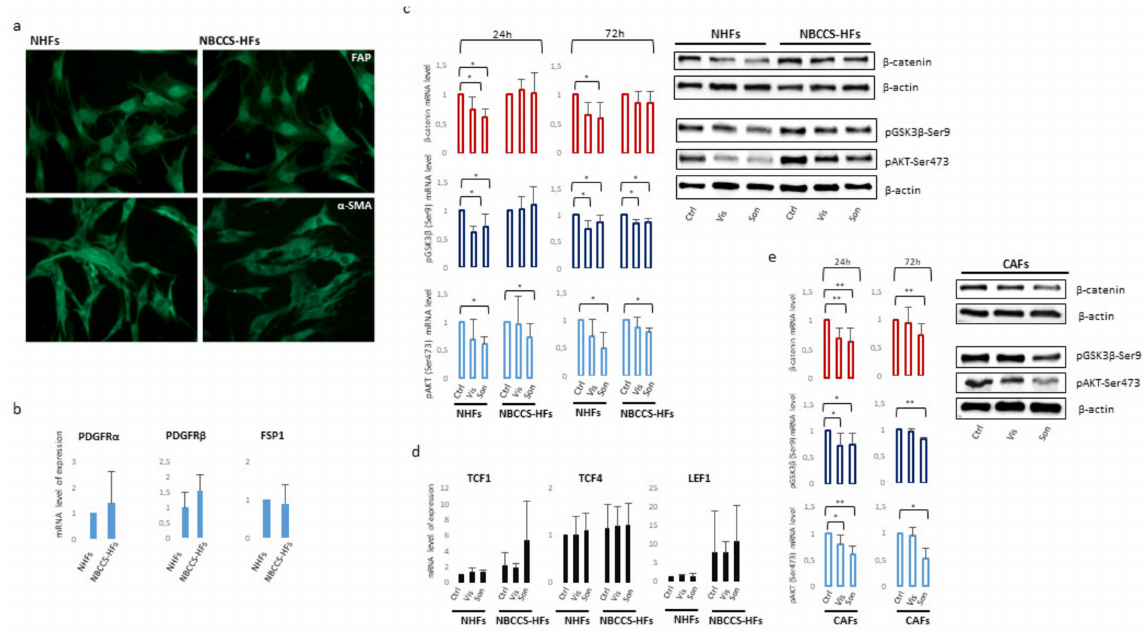
Figure 7. ( a ) Immunofluorescence analysis of α -SMA and FAP protein expression in NBCCS and control cells. Original magnification 20 × . ( b ) Semi-quantitative RT-PCR was performed to assess the level of PDGFR α , β and FSP1 mRNA. Histograms report mean ± SD from 9 NBCCS and 9 NHF cell lines. Value from healthy fibroblasts was arbitrarily indicated as 1.0. ( c ) One representative Western blot detecting β -catenin, pSer9-GSK3 β and pSer473-AKT of NHFs and NBCCS-HFs. Histograms show densitometric analysis mean ± SD of nine independent experiments. * p < 0.05; ** p < 0.01. ( d ) Semi- quantitative RT-PCR was performed to assess the mRNA level of expression Wnt- β -catenin pathway transcription factors LEF1, TCF1 and TCF4. Histograms report mean ± SD from 9 NBCCS and 9 NHF cell lines. Value from healthy fibroblasts was arbitrarily indicated as 1.0. ( e ) One representative Western blot detecting β -catenin, pSer9-GSK3 β and pSer473-AKT of CAFs. Histograms show densitometric analysis mean ± SD of five independent experiments. * p < 0.05; ** p <